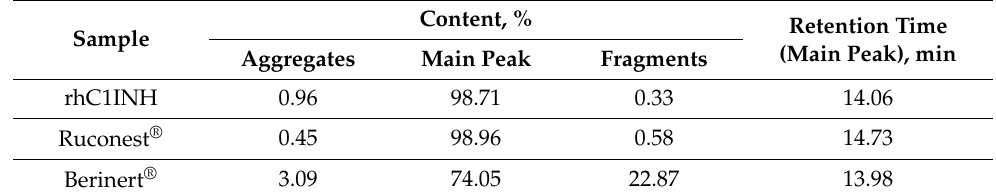
Table 3. The purity of rhC1INH, Ruconest ® and Berinert ® measured by SEC.